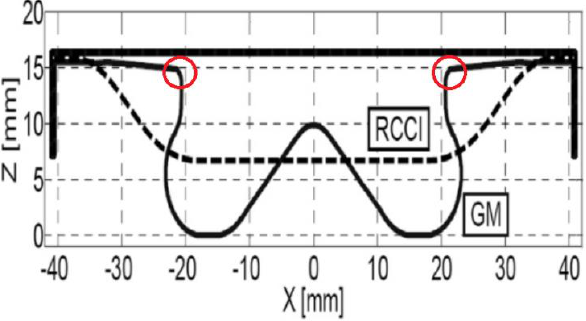
Fig. 13. Cross-section drawing of GM stock piston (solid line) and modi- fied RCCI piston (dotted line) (reproduced from